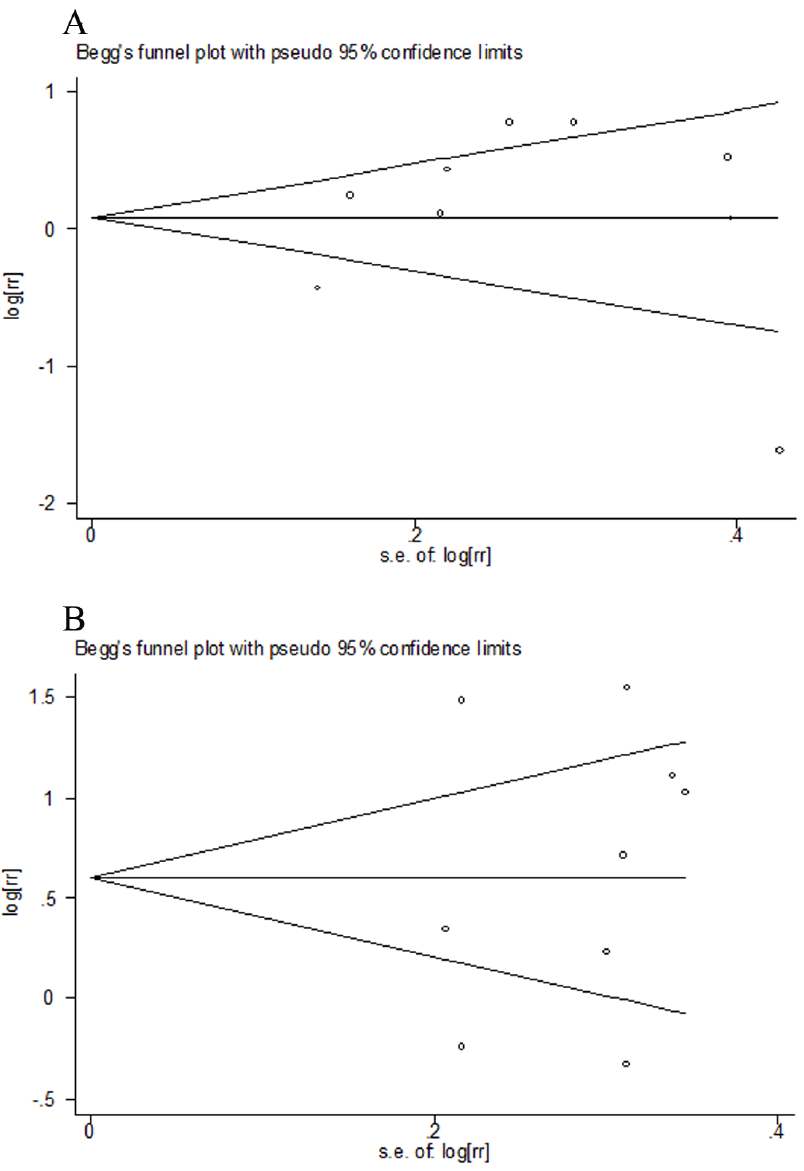
Figure 4. Begger’s funnel plot of publication. A: Funnel plot for studies investigating total meat consumption and risk of oral cavity and oropharynx cancer; B: Funnel plot for studies investigating processed meat consumption and risk of oral cavity and oropharynx